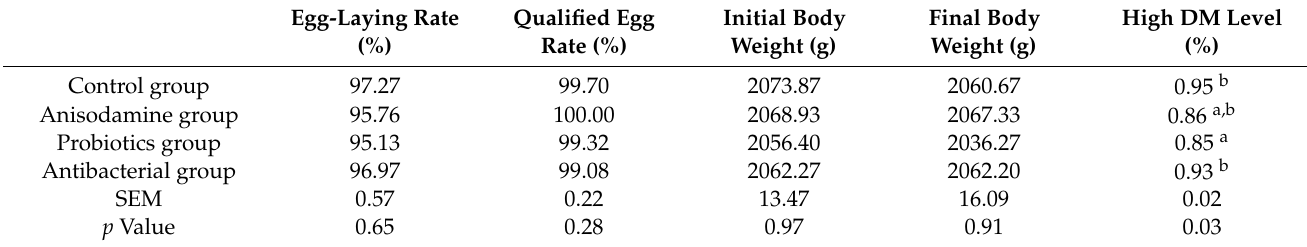
Table 2. The effects of different additives on the production performance and DM level of layers.